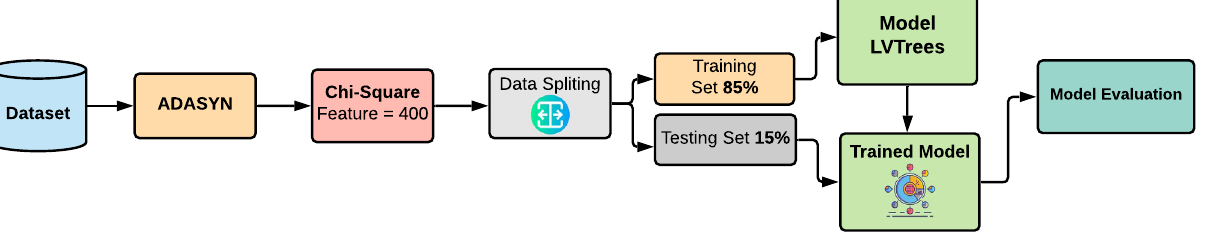
Figure 1. Methodology applied for the study.